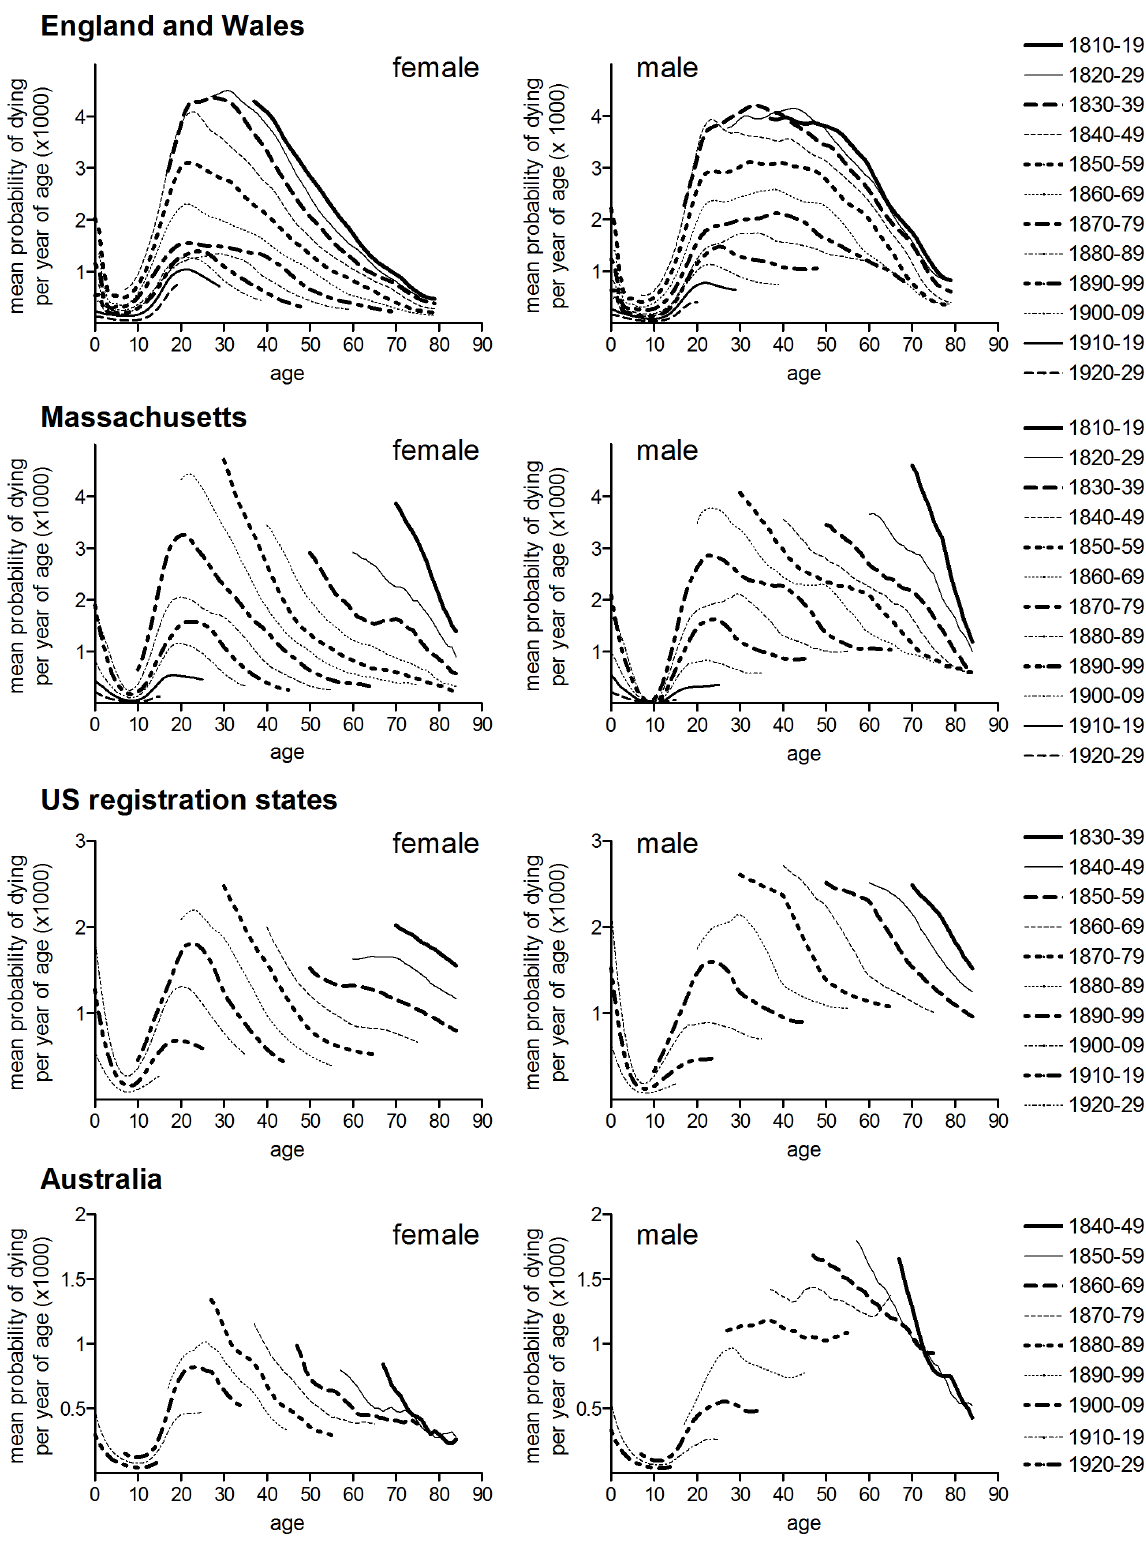
Figure 4. Age-specific tuberculosis mortality by birth cohort. Respiratory tuberculosis (England & Wales, and Massachusetts), all tuberculosis (US death registration states, Australia), plotted by ten year birth cohorts. Legend indicates cohort years of birth. Rates for years after 1945 were excluded.